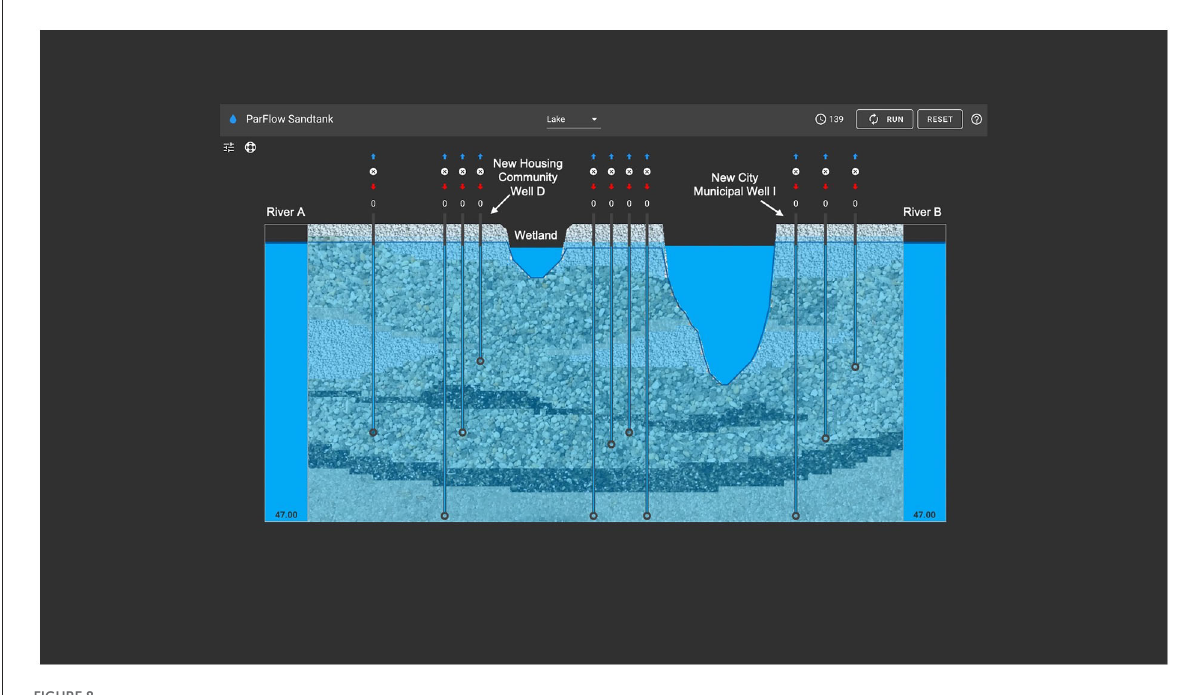
FIGURE8 Labeled PFST features for Dr. Sandy Loam’s